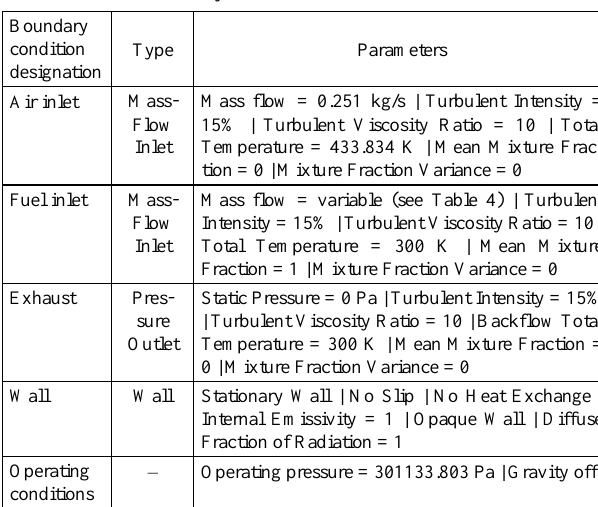
Table 3. Boundary conditions obtained from